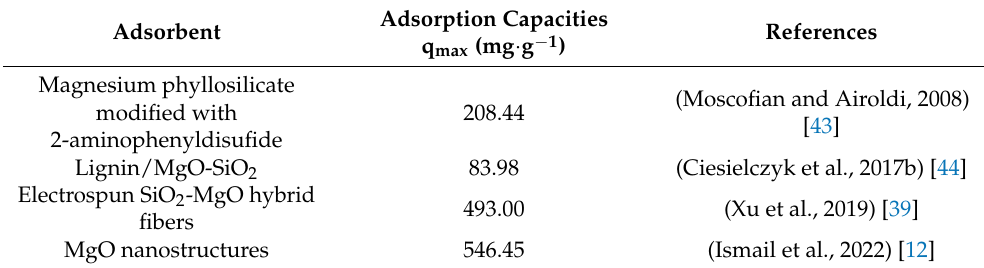
Table 4. Comparison of copper’s adsorption capacities (mg · g − 1 ) using magnesium oxide as adsorbent. Adsorption Adsorbent